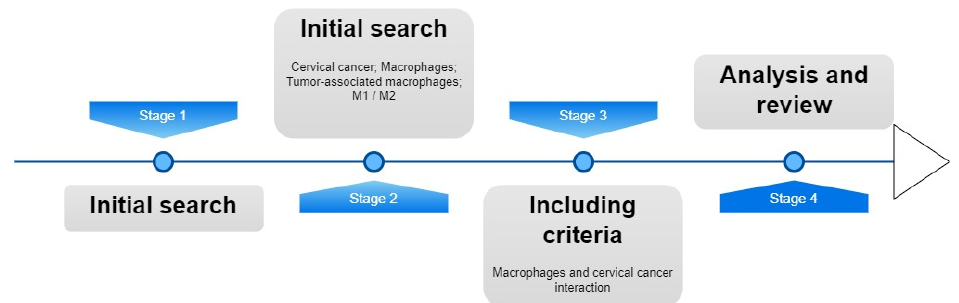
Figure 1. Study development step-by-step. Stage 1 and 2 consisted in an initial search using cervical cancer related keywords. In stage 3 occurred the selection of studies relating macrophages and cervical cancer. Stage 4 comprised the analysis of such studies and the compiling of information.